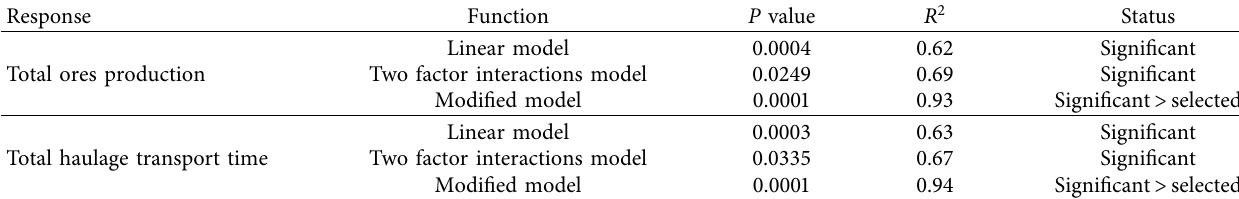
Table 5: Accuracy model of responses for three candidate regression functions.